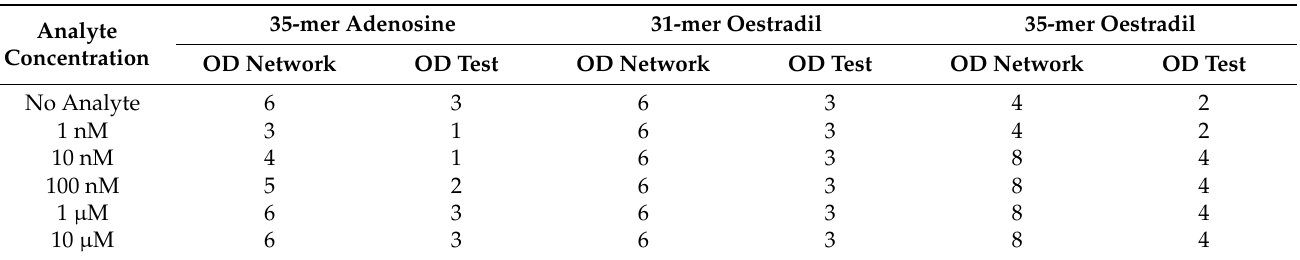
Table 6. The number of available segments for the OD network and the OD test sets that were relevant to each dataset.